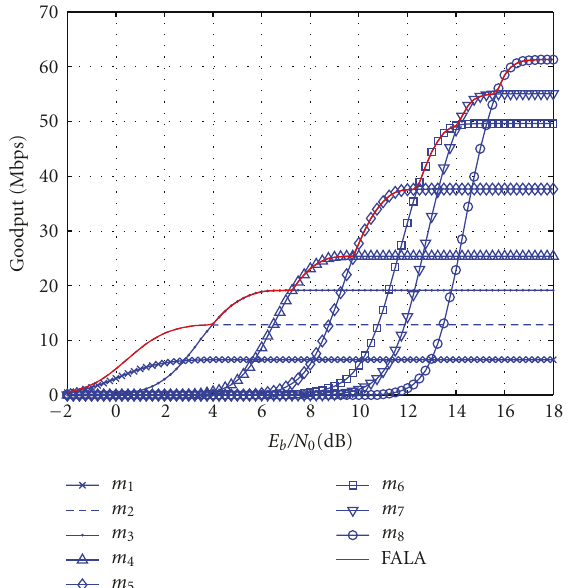
Figure 5: Maximal achievable goodput performance by adopting FALA algorithm and the eight MCS schemes.